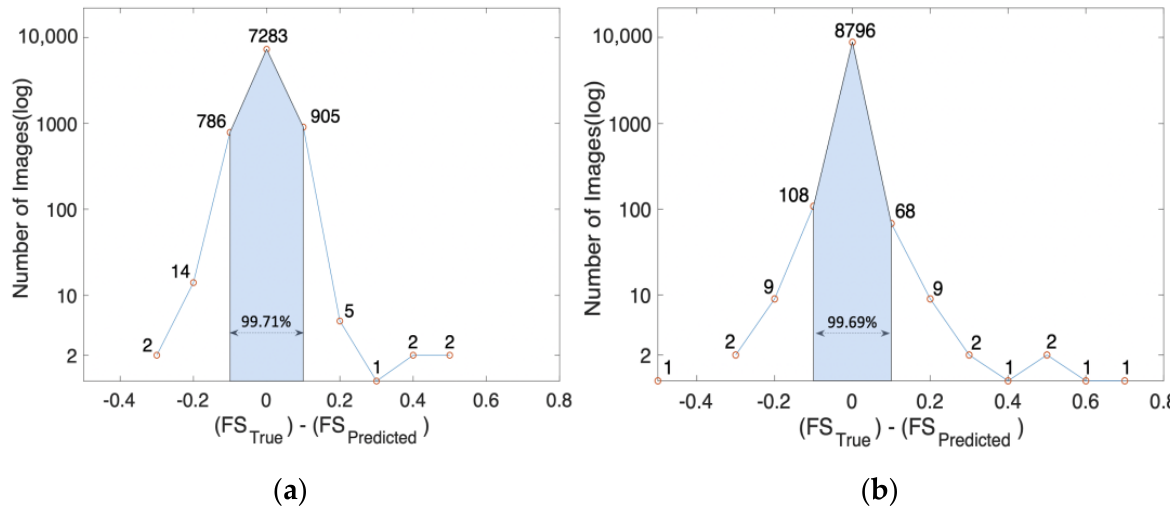
Figure 8. Number of images versus error in FS predictions for ( a ) the classification model and ( b ) the regression model. To further evaluate the effect of this loss of information, 500 random slope images were selected from the testing data. In Figure 9, the predicted range of FS values obtained by the classification model is compared with the true FS values. In this figure, the vertical axis is the true FS value of each point or image, and the horizontal axis is the predicted FS value. It is important to note that the classification model predicts the range of FS s, and the horizontal placement of points within a single range is for plotting purposes. The points that are located within the green boxes represent cases in which the predicted FS value was correct. By contrast, the points in red boxes belong to incorrectly predicted ranges. This figure shows that for the majority of the incorrectly predicted cases, the true FS value was quite close to the boundaries of the FS ranges defined for the classification model. This confirms that the loss of information made it difficult for the classification model to predict the range of FS values when the true FS was close to the cell